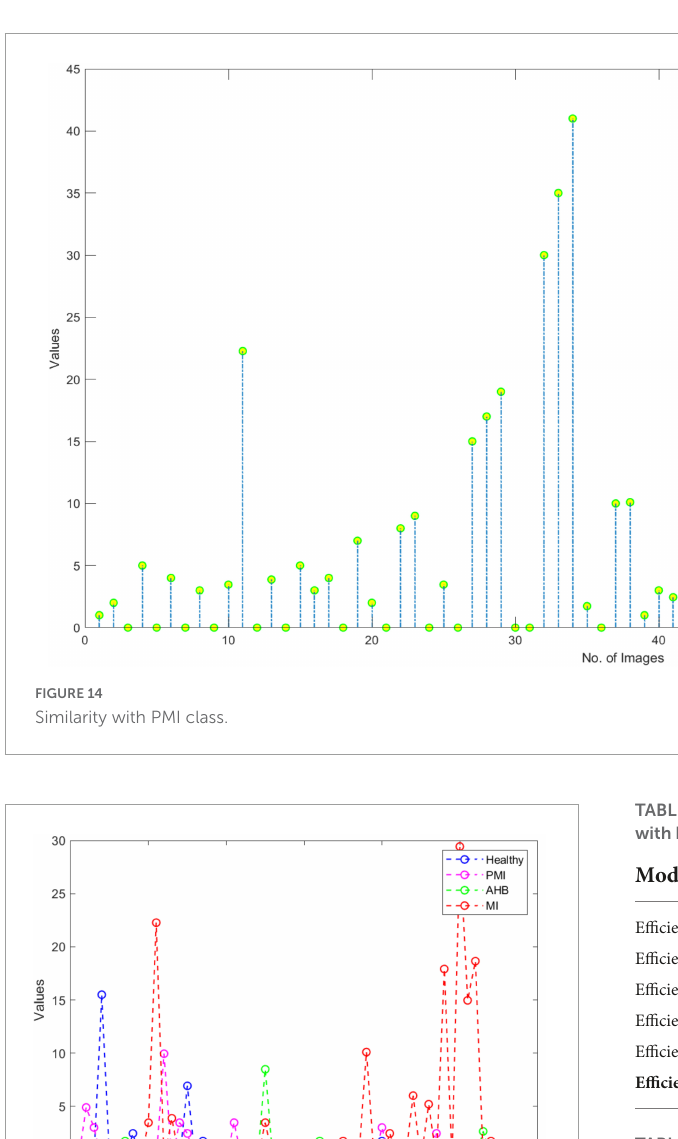
TABLE 4 Overall performance evaluation with base